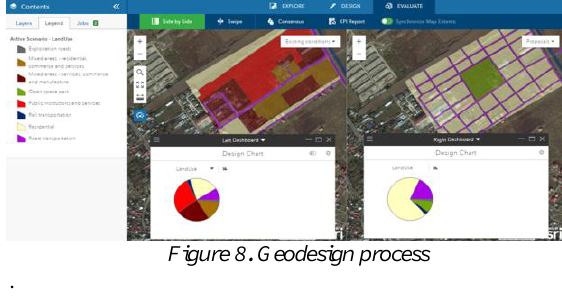
Figure 8. Geodesign process